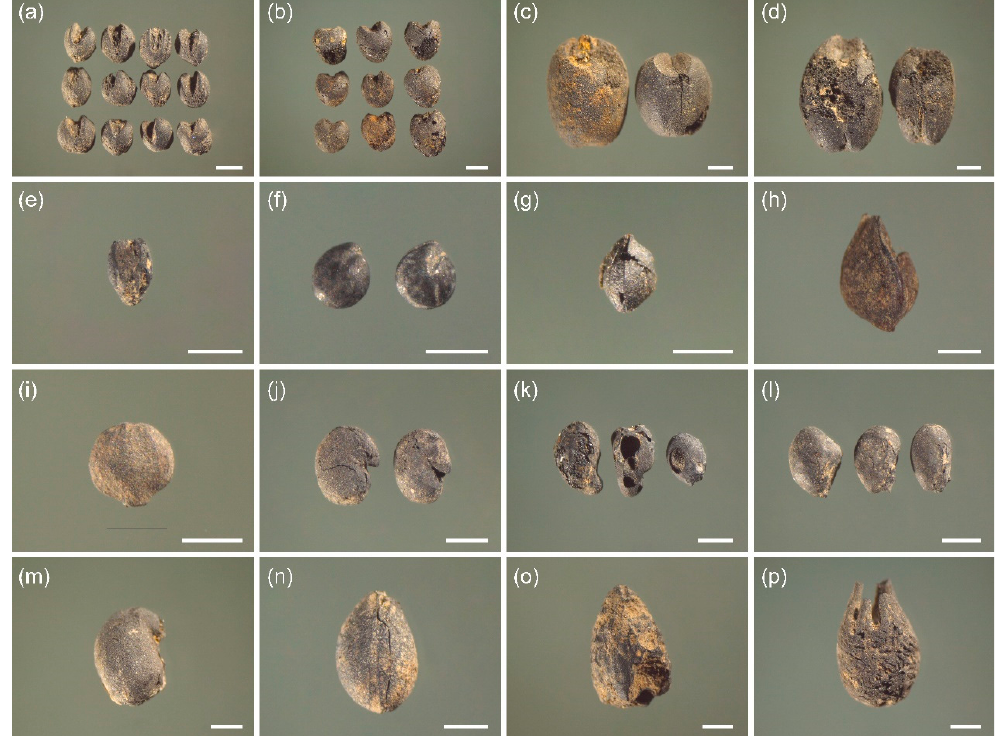
Figure 2. Carbonized plant seeds unearthed from Haizang site in the Hexi Corridor. ( a ) Foxtail mil- let ( Setaria italica ); ( b ) Broomcorn millet ( Panicum miliaceum ); ( c ) Wheat ( Triticum aestivum ); ( d )